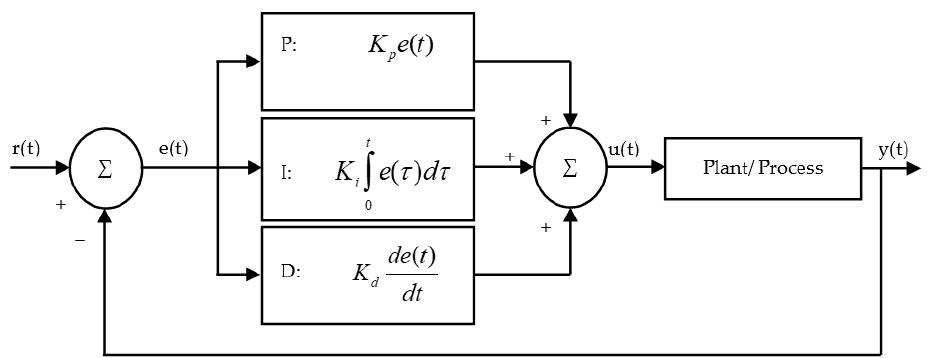
Figure 10. The diagram of a Proportional-Integral-Derivative (PID) controller.